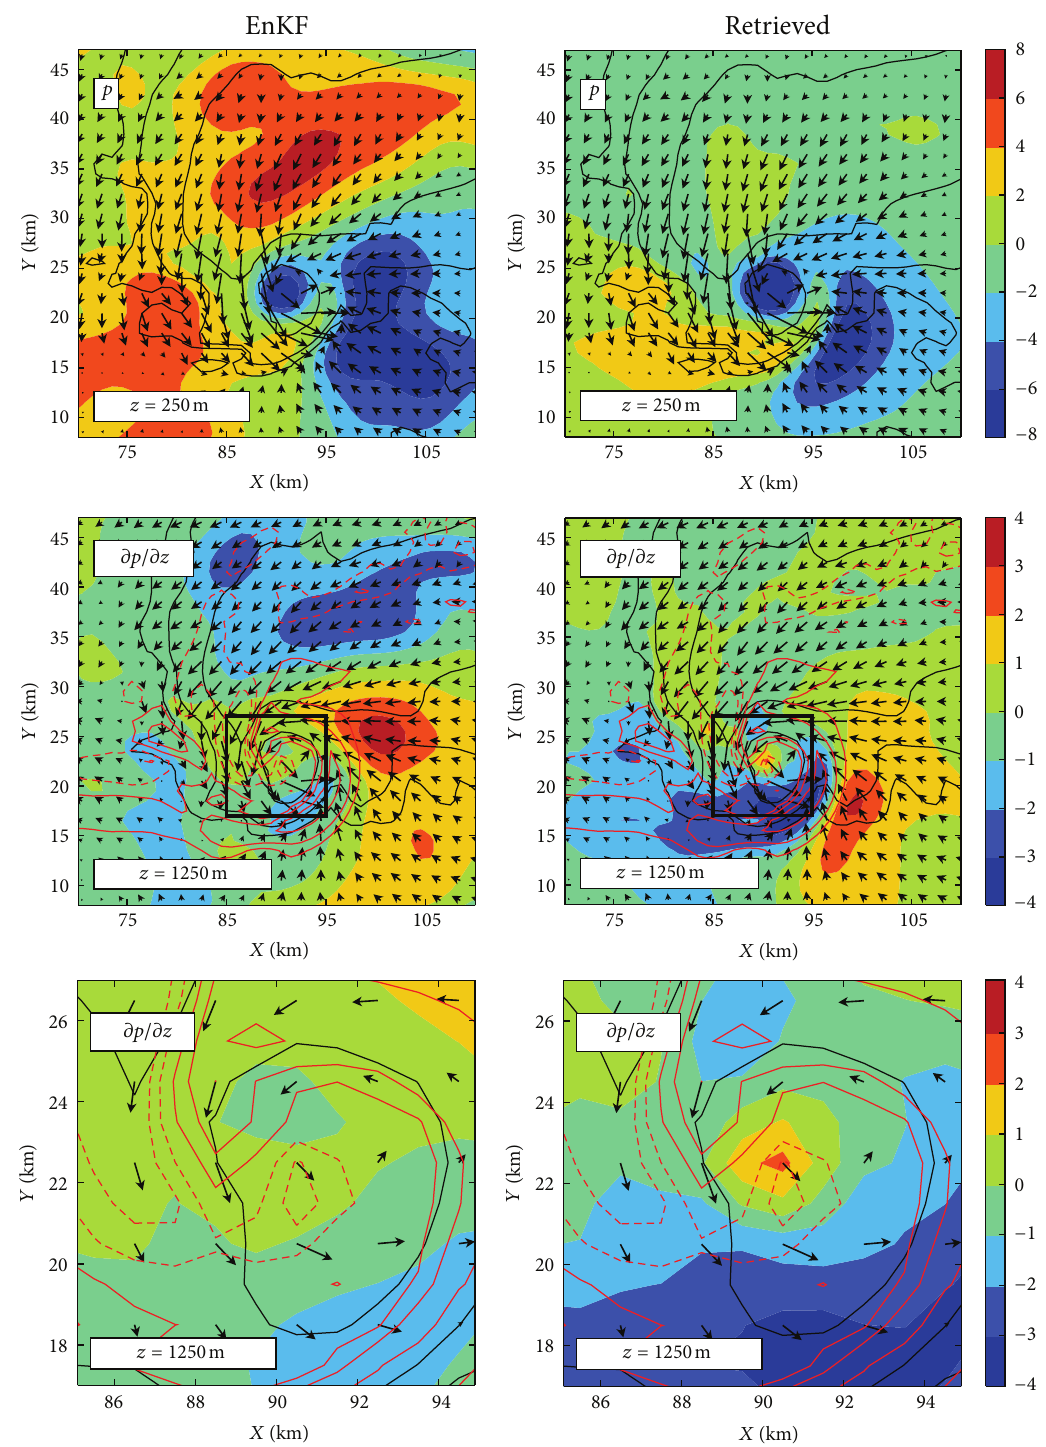
Figure10:EnKFmeanposterior(leftcolumn)andretrieved(rightcolumn) 𝑝 at 𝑧 = 250 m(hPa;toprow)and 𝜕𝑝/𝜕𝑧 at 𝑧 = 1250 m(hPakm −1 ; middle and bottom rows). The black squares in the middle row outline the domain (centered near the occlusion updraft) in the bottom row. EnKF mean posterior vertical velocity (red; dashed = negative) is contoured at − 5, − 2, 2, and 5ms −1 and radar reflectivity factor (black) at 10, 30, and 50dBZ. Arrows represent EnKF mean posterior horizontal